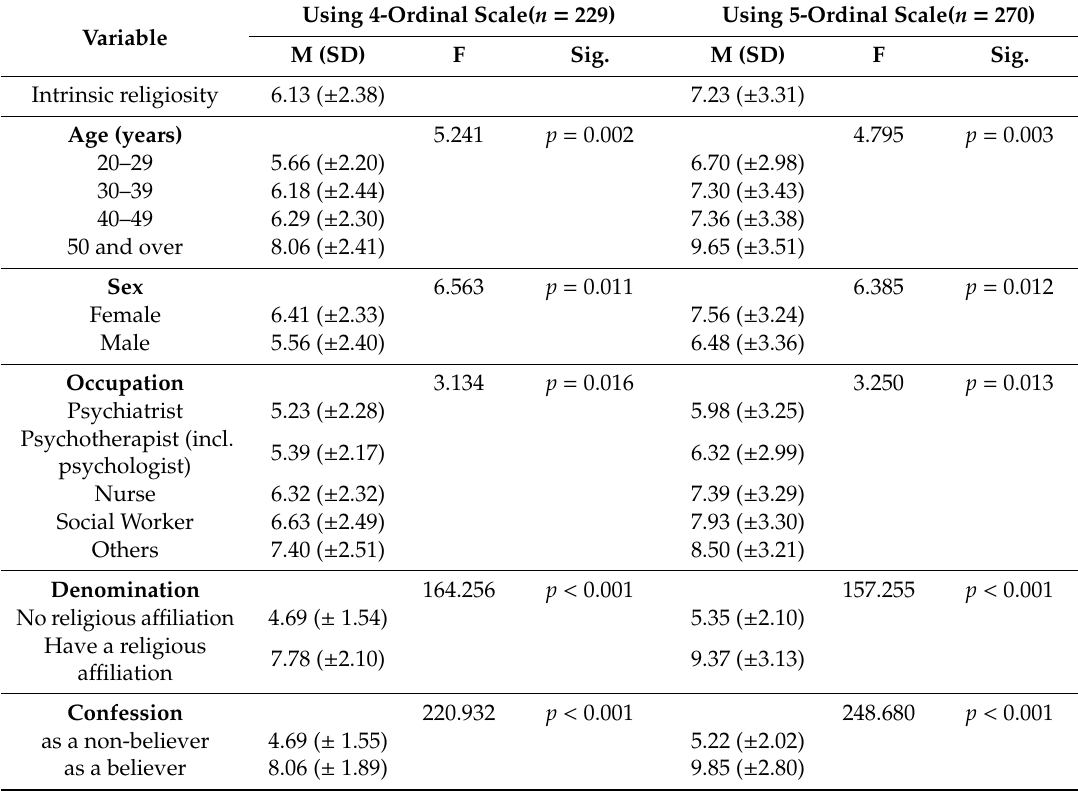
Table A1. Comparison between intrinsic religiosity scores using a 4-ordinal scale and 5-ordinal scale.